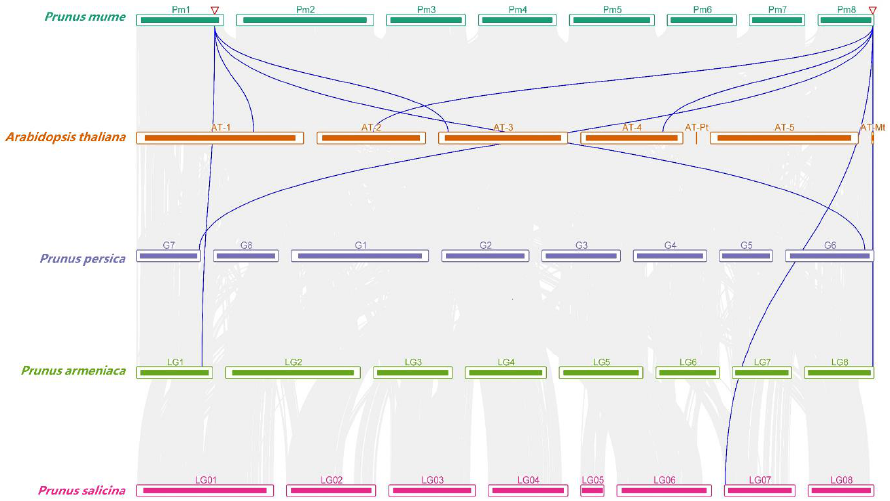
Figure 4. Syntenic analyses of RCI2s in P. mume and other plants. Blue lines represent syntenic RCI2 gene pairs.